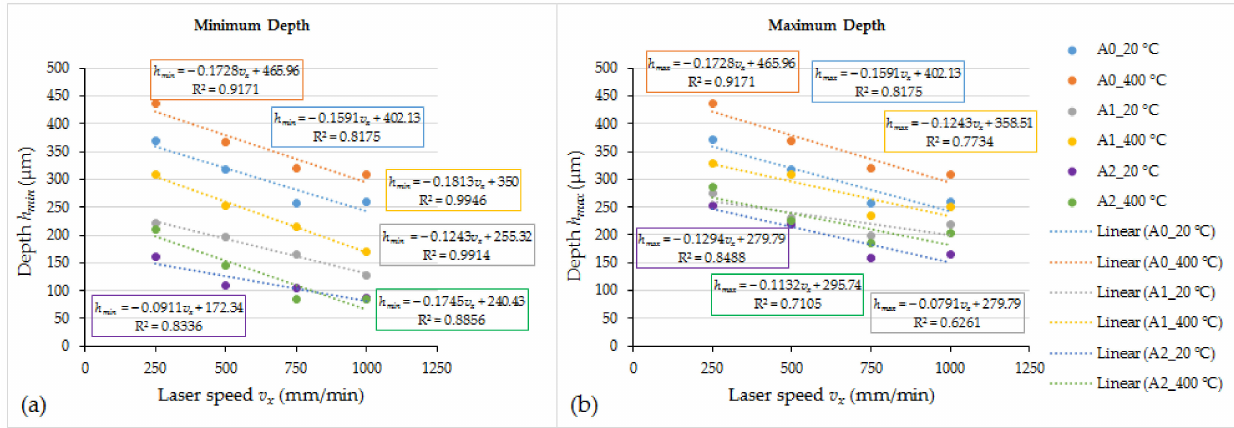
Figure 6. The relationship between the minimum ( a ) and the maximum ( b ) depth of molten pools and laser operating speed, applied oscillation amplitude and preheating temperature; for non-oscillated molten pools h min = h max ; oscillation amplitude A0—0 mm (no oscillation); oscillation amplitude A1—1 mm; oscillation amplitude A2—2